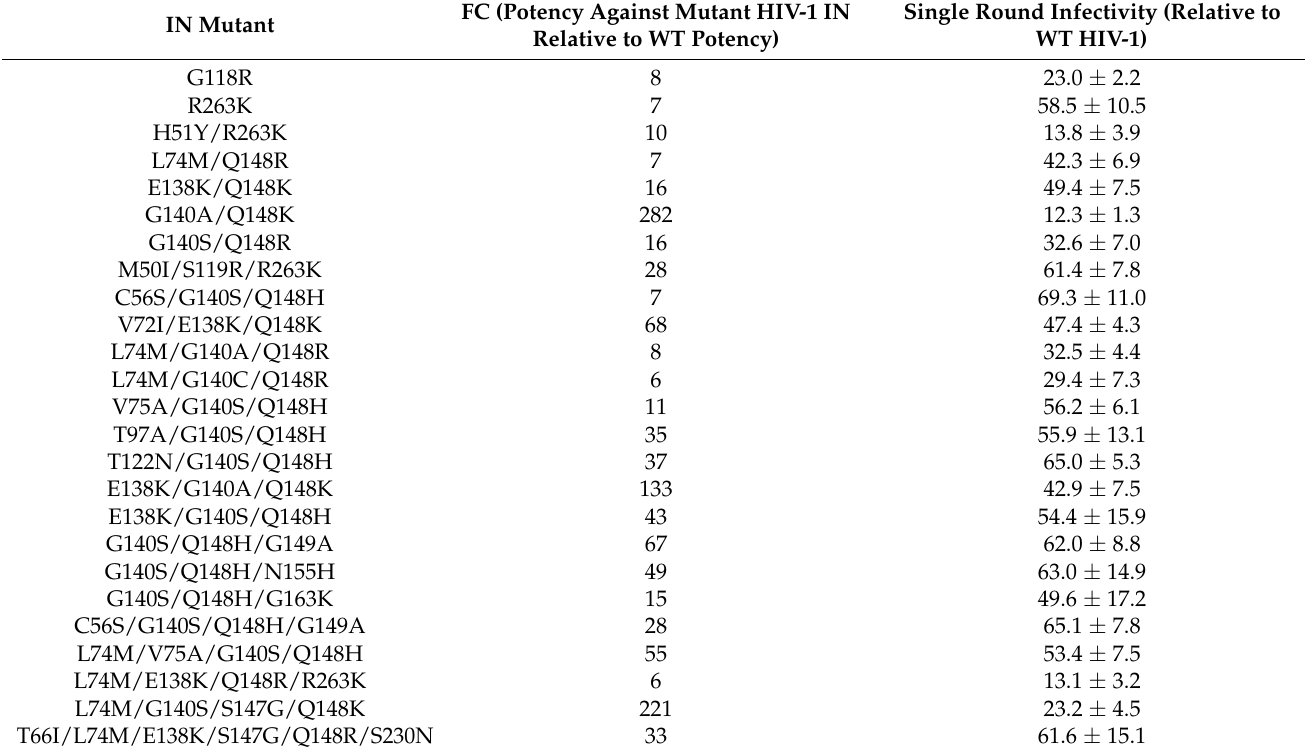
Table 3. IN mutants selected by dolutegravir (DTG). Single, double, and triple IN mutants that have been selected by DTG in patients, in vitro selection studies, or IN susceptibility assays are listed. The FC, the potency of DTG against the IN mutant relative to its potency versus WT HIV-1 as determined by single round replication assay, is also shown as are the single round infectivity of the IN mutant relative to WT HIV-1. FC (Potency Against Mutant HIV-1 IN Single Round Infectivity (Relative to IN Mutant Relative to WT Potency) WT HIV-1) G118R 8 23.0 ±